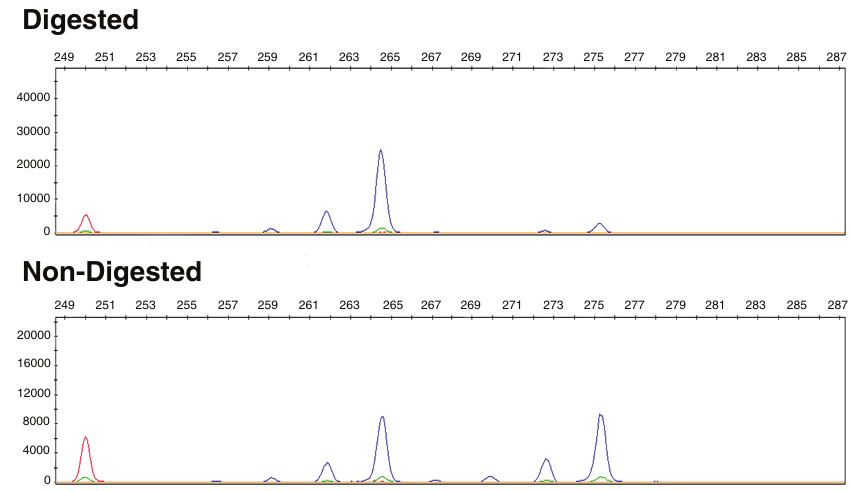
Figure 1. Clonal hematopoiesis in patient CHOP 277.01. The panel at the bottom shows the migration of the 2 microsatellite alleles in patient CHOP277.01 revealed by PCR analysis of a region of the Androgen receptor gene on the X-chromosome. The amplified region contains both a polymorphic repeat and a site for the methylation sensitive restriction enzyme HhaI. This site is methylated on the inactive X-chromosome. The top panel shows the same sample digested with HhaI before the PCR so only the fragment on the inactive X-chromosome is amplified. An imbalance in the allelic ratio reflects an imbalance in X inactivation and therefore indicates clonality.